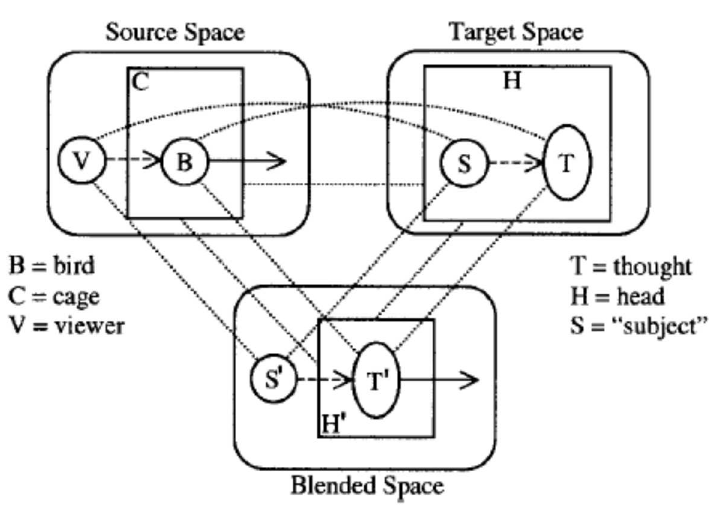
Figure 1. The THOUGHT IS A BIRD metaphor tion of the expression. The verb fly proves rather instrumental, in that it evokes not only the conceptual element BIRD but also the conceptual element CAGE it conventionally collocates with. Though not linguistically encoded in the expression, CAGE is a salient element in the conceptual materials that are carried over to the target input. As such, it is systematically linked to the element HEAD